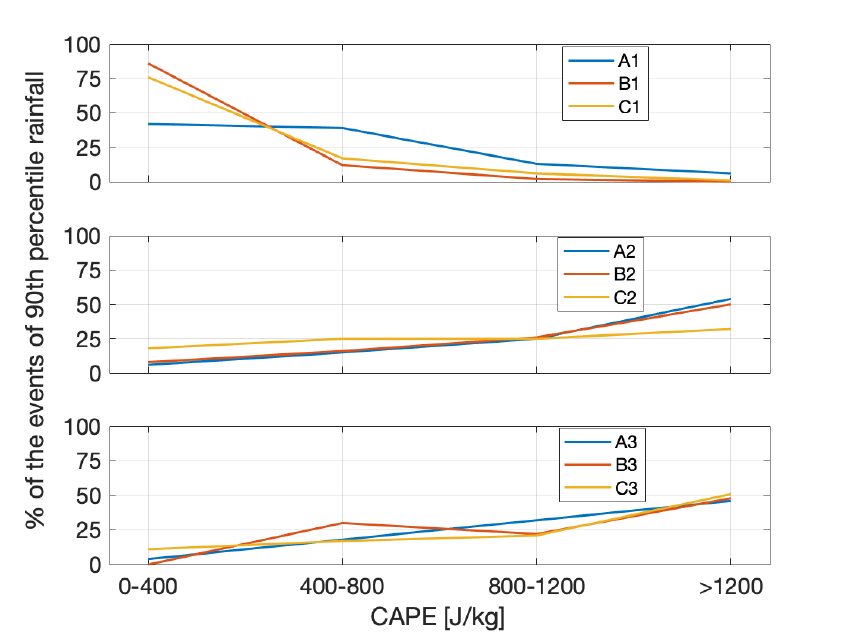
Figure 14. Line plot showing the percentage of the events of 90th percentile rainfall for different value ranges of CAPE. We show higher values of CAPE for most of the events of 90th percentile rainfall over low-elevation foreland and intermediate-elevation areas as compared to Altiplano region. Based on root mean squared error (RMSE) values, uncertainties decrease with increasing percentiles. This argues that rainfall can not be explained reasonably at the low percentile (50th) using CAPE and T d (Figure